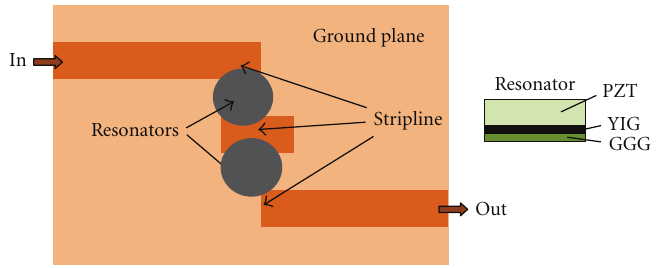
Figure 5: Schematic diagram showing a dual-cavity magnetoelectric filter and the ME